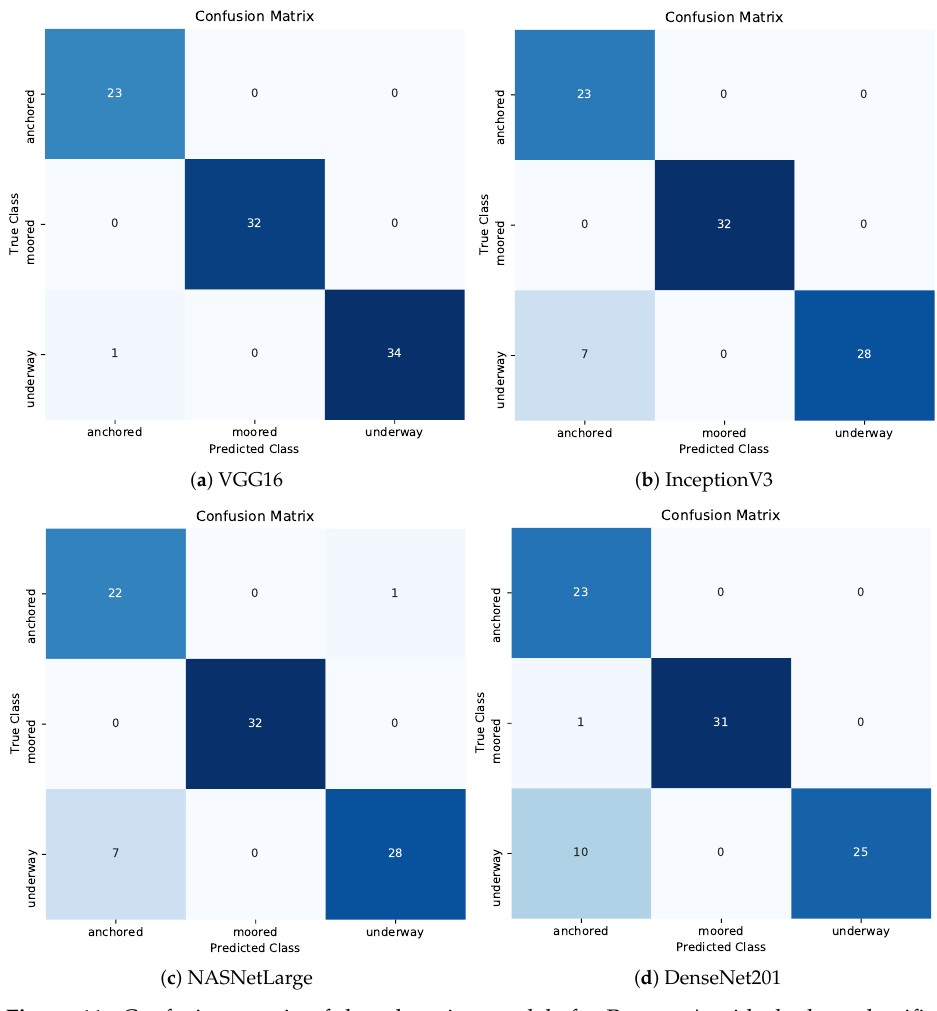
Figure 11. Confusion matrix of deep learning models for Pattern A with the best classification performance out of the five folds.